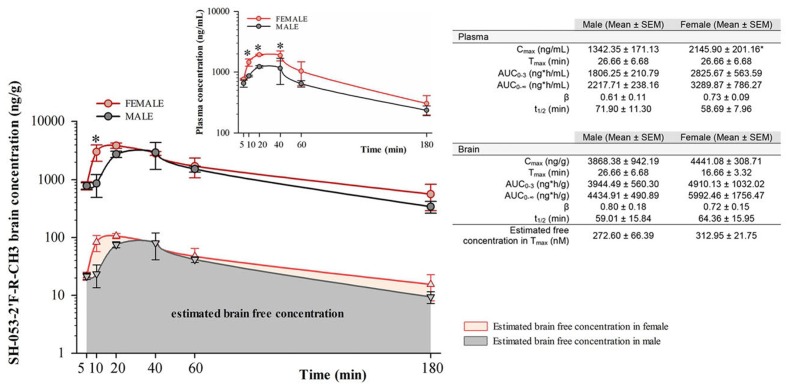
Pharmacokinetic analysis of α5-PAM brain and plasma levels in female and male mice. Brain (main figure) and plasma (inset) concentration–time profiles of α5-PAM (30 mg/kg) after intraperitoneal administration (n = 3 per time point), with estimated free brain concentration in female and male mice. ∗p < 0.05 between female and male mice in different time-points, according to Tukey post hoc test after two-way repeated ANOVA. The calculated plasma and brain pharmacokinetic parameters of α5-PAM are tabularly presented on the right. ∗p < 0.05 between female and male mice according to t-test.